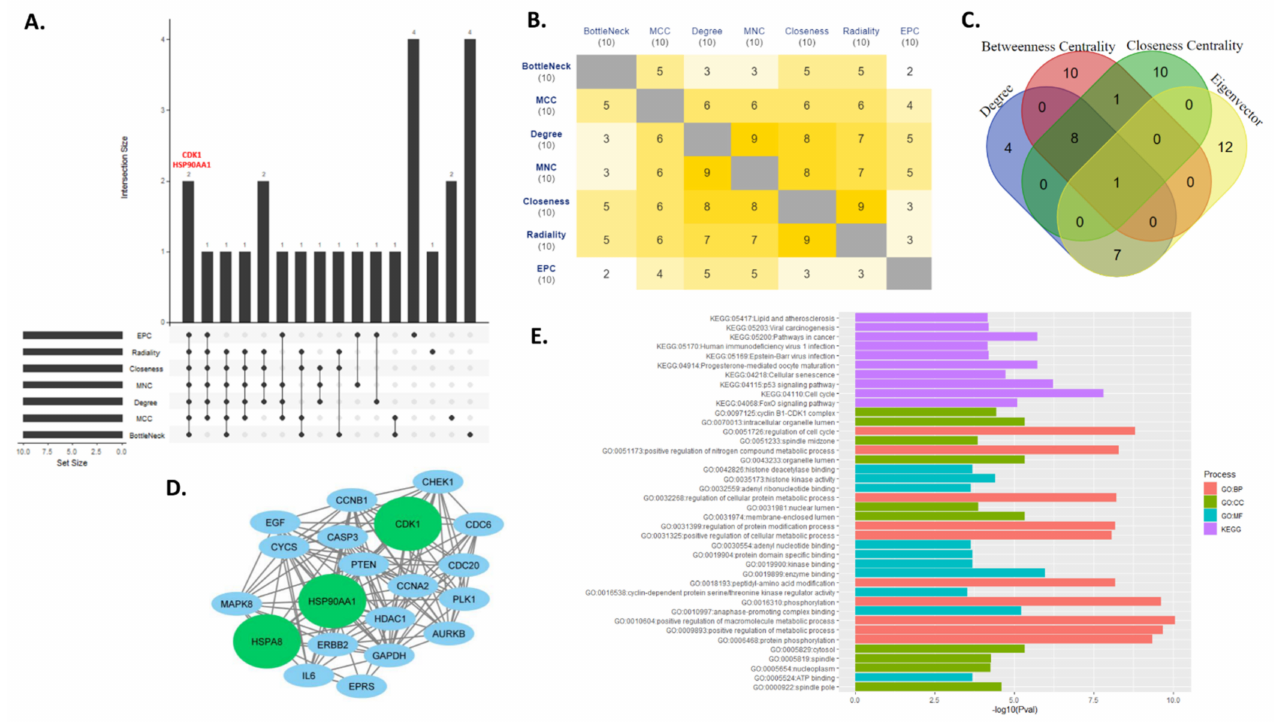
Figure 7. ( A ) Identifying common genes among seven topological properties. The first bar in the upset plot denotes two genes CDK1 and HSP90AA1 are common among top ten genes of each of the seven topological parameters. ( B ) Mutual intersections of each of the seven topological properties are shown as heat maps. ( C ) Intersections among top twenty genes having highest degree, betweenness centrality, closeness centrality and eigenvector values. ( D ) regulatory network of top 20 hub genes (top twenty genes ranked by degrees). ( E ) p -values are used to color a bar graph of enriched terms for a regulatory network of top-20 hub